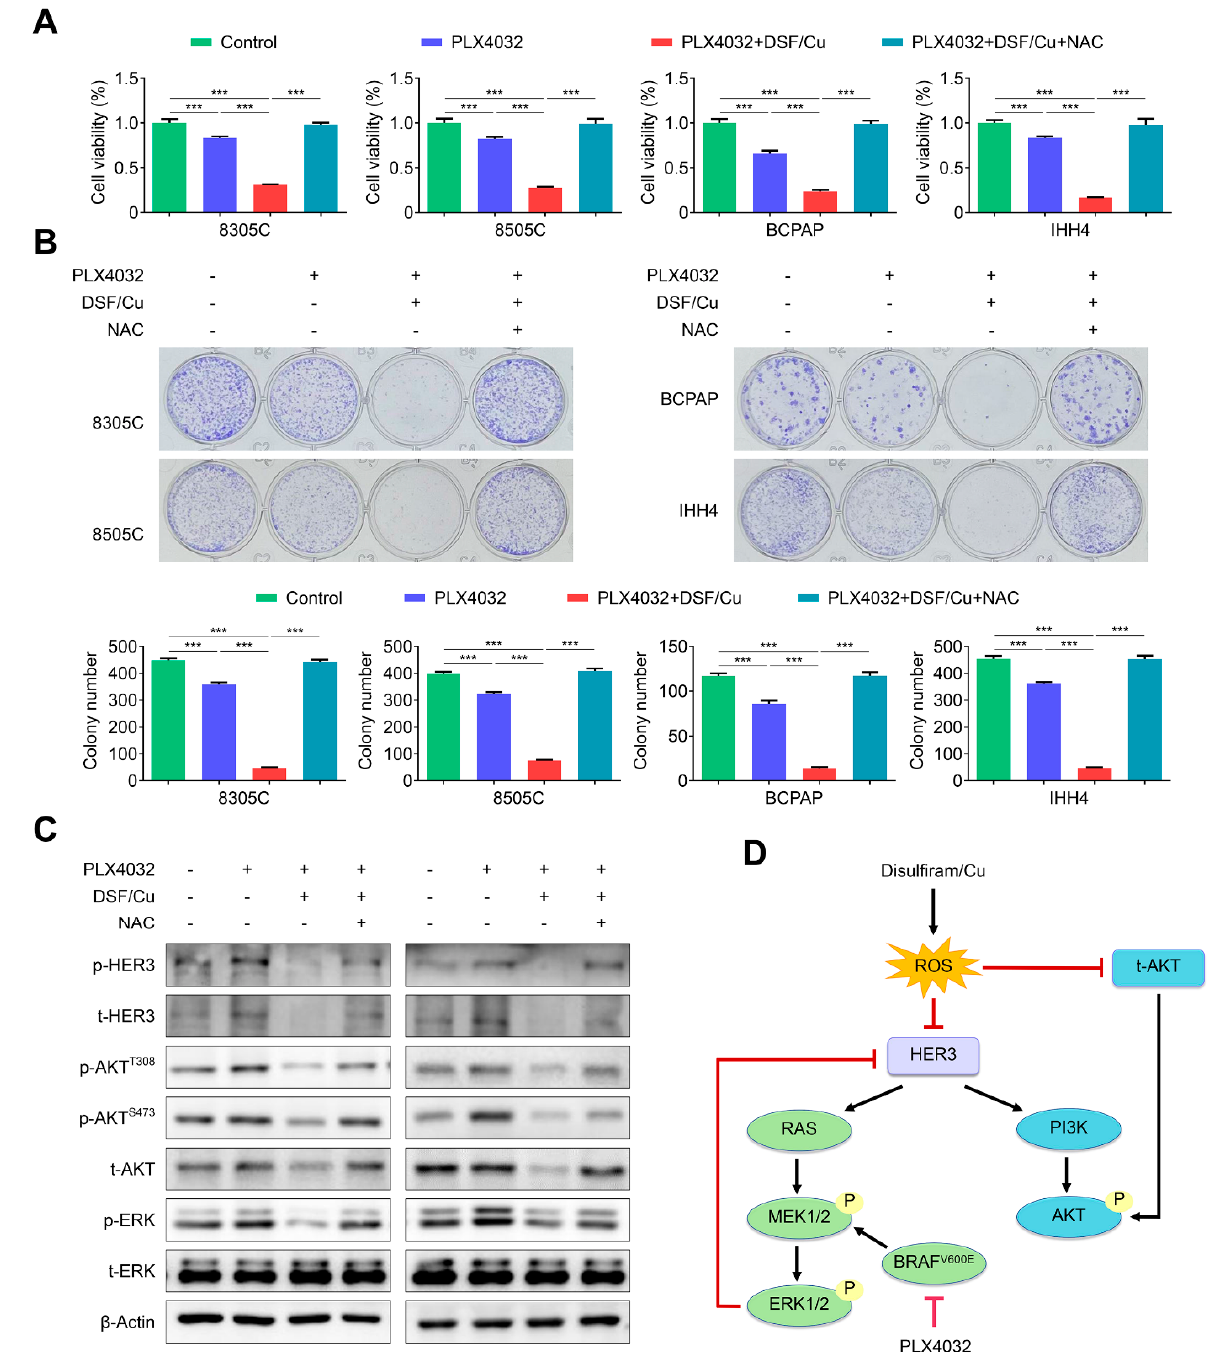
Figure 7. DSF/Cu improves antitumor effect of PLX4032 by ROS-dependently alleviating the feed- back activation of HER3 signaling. ( A ) The indicated cells were treated with vehicle control, 2 µ M PLX4032, and 2 µ M PLX4032 plus 100 nM DSF/Cu with or without 2 mM NAC for 48 h, and their effects on cell proliferation was determined by MTT assay. ( B ) Colony formation was evaluated in the above cells with the indicated treatments for 9 days. ( C ) Western blot analysis of t- HER3 , p- HER3 , t-AKT, p-AKT S473 , p-AKT T308 , t-ERK and p-ERK in the indicated cells with 4 µ M PLX4032, and 4 µ M PLX4032 plus 0.5 µ M DSF/Cu with or without 2 mM NAC for 48 h. ( D ) A schematic model of DSF/Cu improving the response of BRAF V600E -mutated thyroid cancer cells to PLX4032. Data presented as means ± SD. *** p < 0.001.